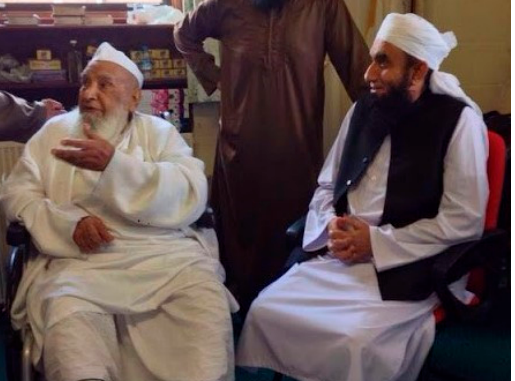
Figure 4. Maulana Tariq Jamil with Hafiz Muhammad Patel, the late am ī r of the Tablighi Jama’at in Europe and the Americas, at the movement’s European headquarters in Dewsbury, England. Source: respondent’s photo.